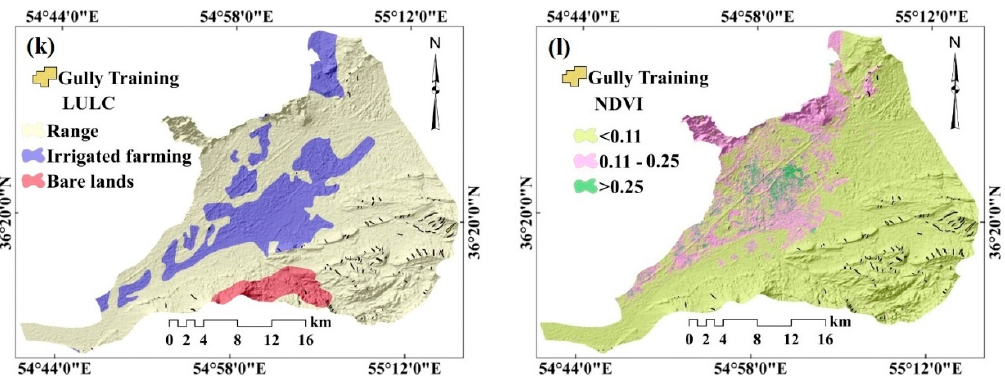
Figure 3. Gully erosion conditioning factors: ( a ) Elevation, ( b ) slope, ( c ) aspect, ( d ) plan curvature, ( e ) TWI, ( f ) convergence index, ( j ) geology, ( h ) distance from road, ( i ) drainage density, ( g ) distance from road, ( k ) land use/land cover (LU/LC), and ( l ) NDVI.